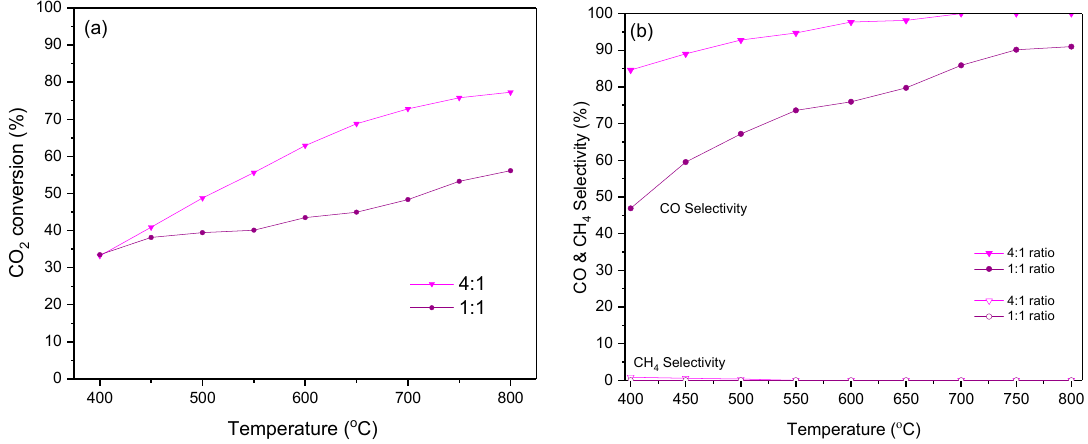
Figure 7. ( a ) CO 2 Conversion and ( b ) CO and CH 4 selectivity at 400–800 °C, WHSV of 12,000 mL/g cat h, and various H 2 /CO 2 ratios using 5% CsFe/Al 2 O 3.